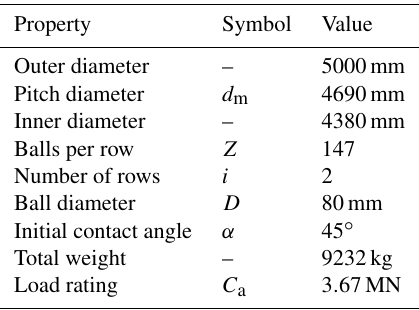
Table 2. Main properties of blade bearing investigated (cf. Stamm- ler et al.,